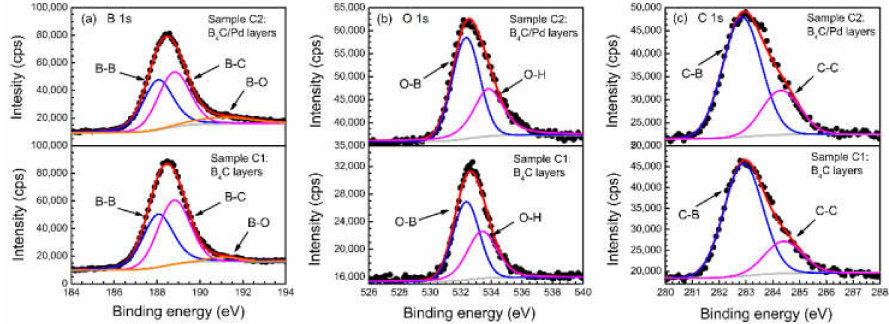
Figure 5. The X-ray photoelectron spectroscopy (XPS) spectra of the B 4 C film and B 4 C/Pd layers placed in the dry oxygen-rich environment. ( a ) B 1s, ( b ) O 1s, and ( c ) C